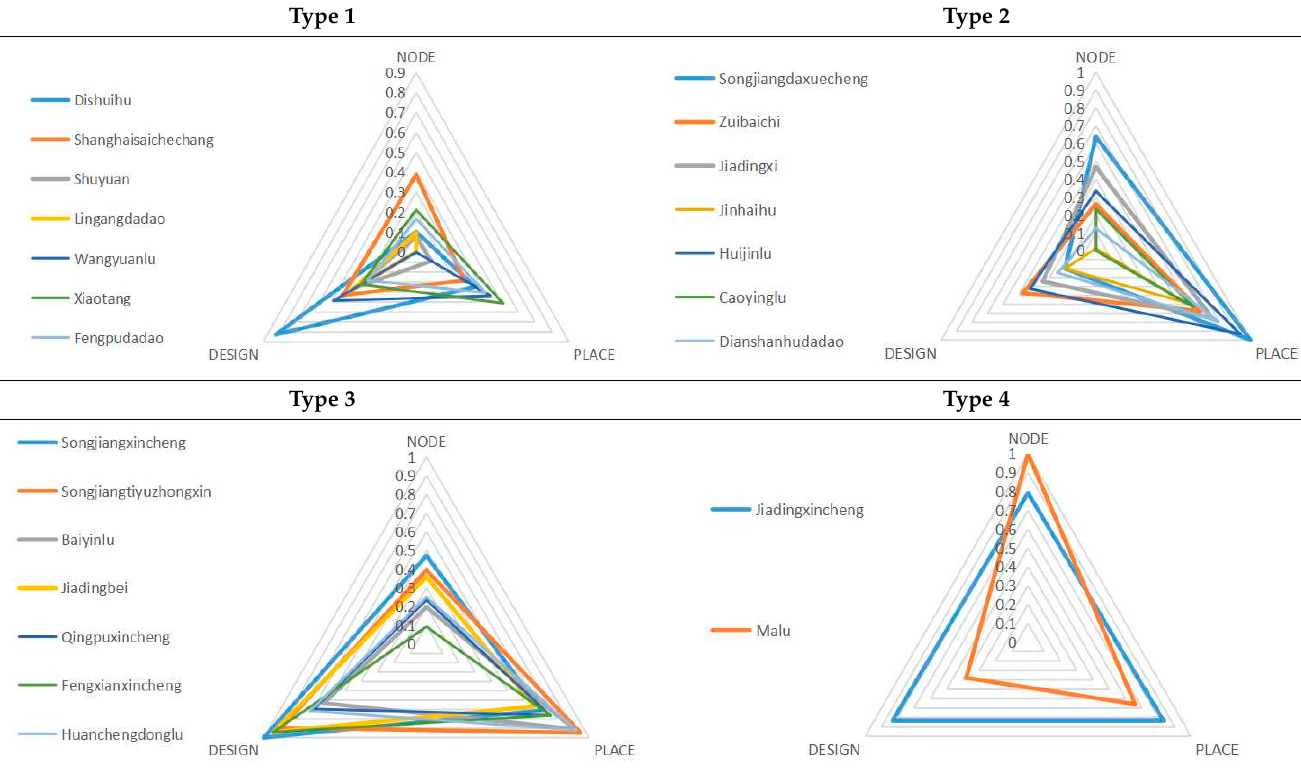
Figure 9. Hierarchical cluster analysis based on three dimensions. Table 3. Rader charts for each dimension by types.